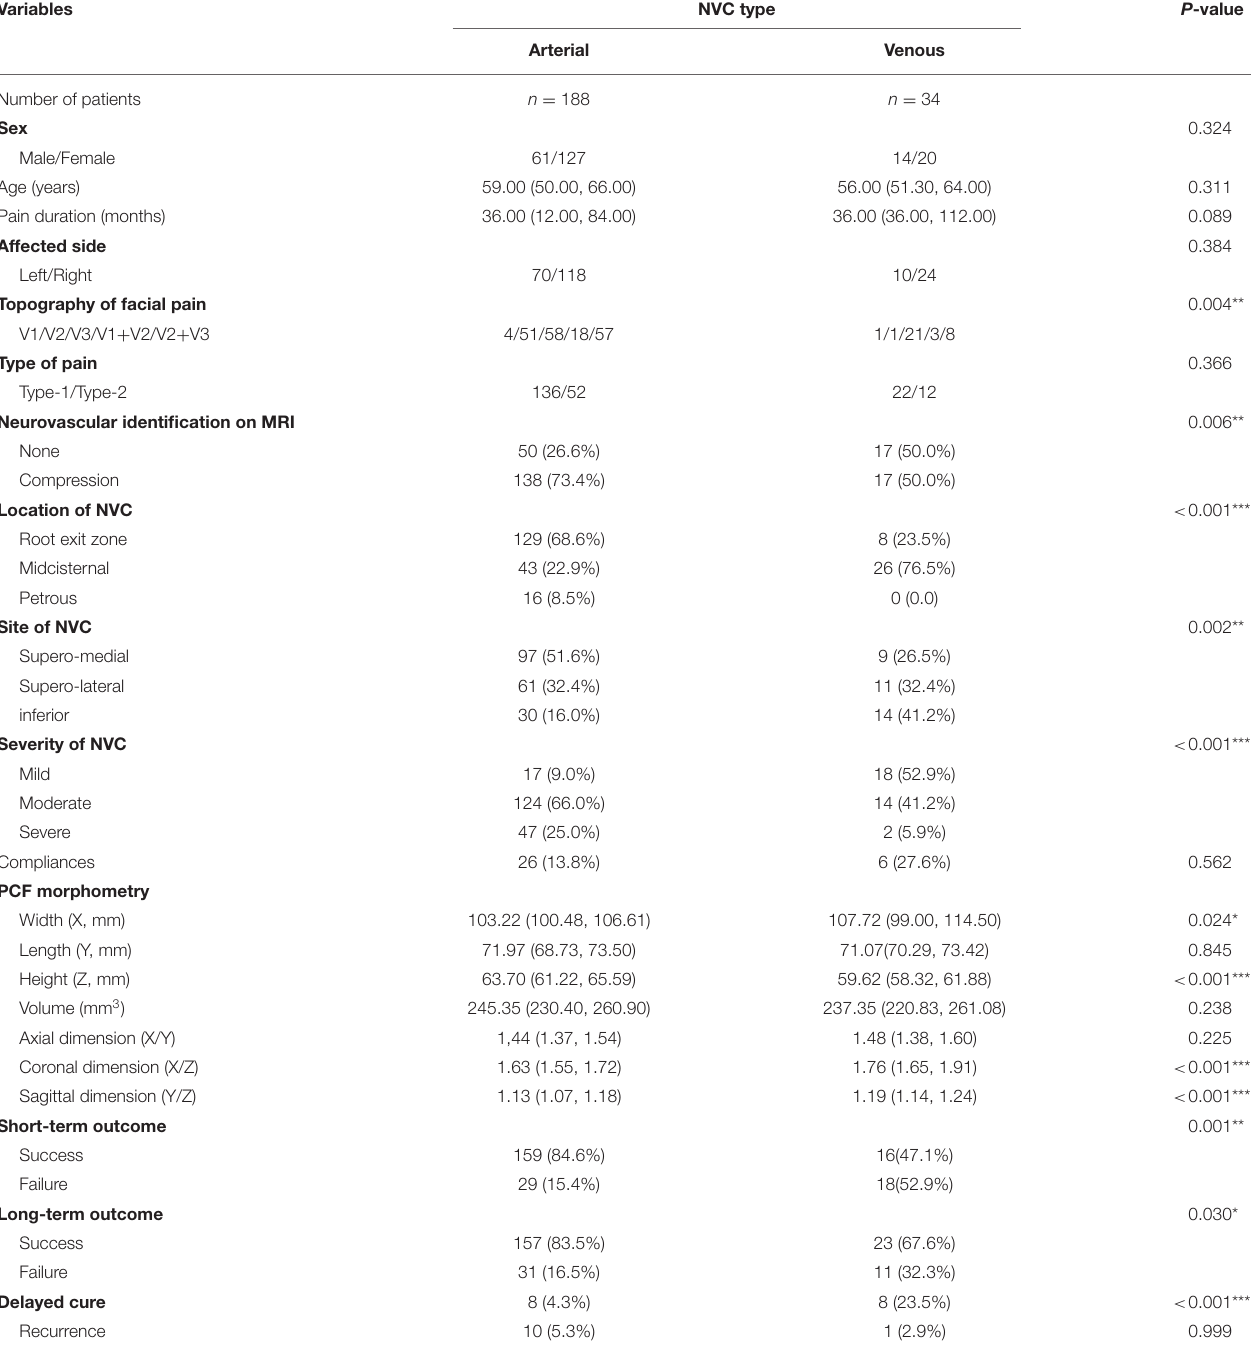
TABLE 2 | Comparative analysis of classic TN patients with different type of NVC.